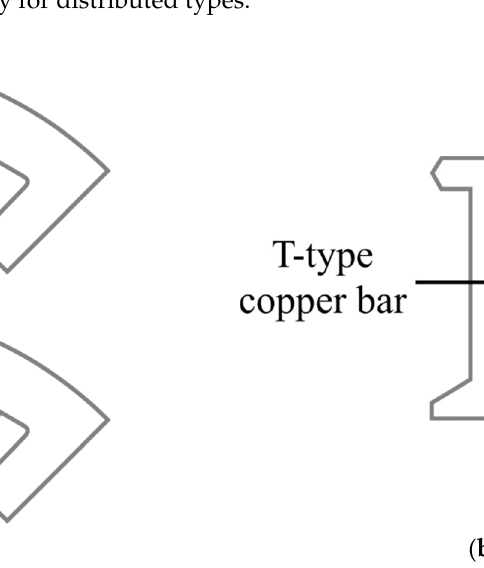
Figure 8. Winding hotspot reduction through iron extension or heat pipe insertion: ( a ) back-iron lamination extension [80]; ( b ) T-section heat pipe [81].